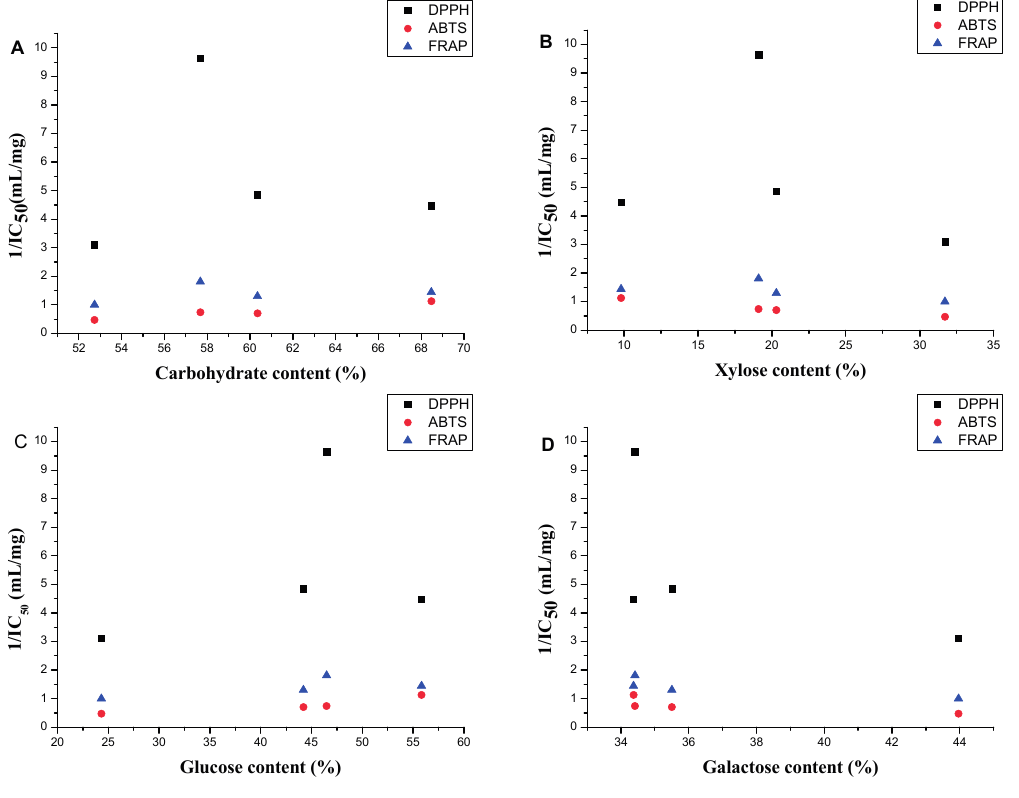
Figure 5. Scatter diagram for the antioxidant 1/IC 50 values and ( A ) carbohydrate content, ( B ) xylose percentage; ( C ) glucose percentage and ( D ) galactose percentage in four A. mellea